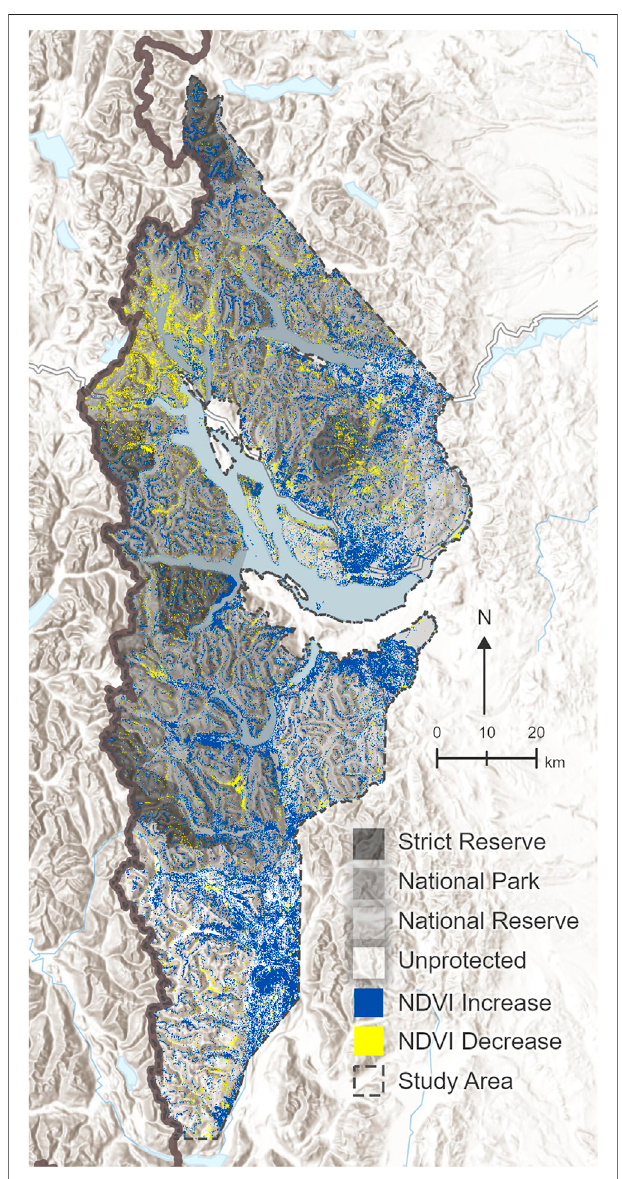
FIGURE 9 | Map with areas with NDVI increase (blue) and decrease (yellow) in the period 2000 – 2020.